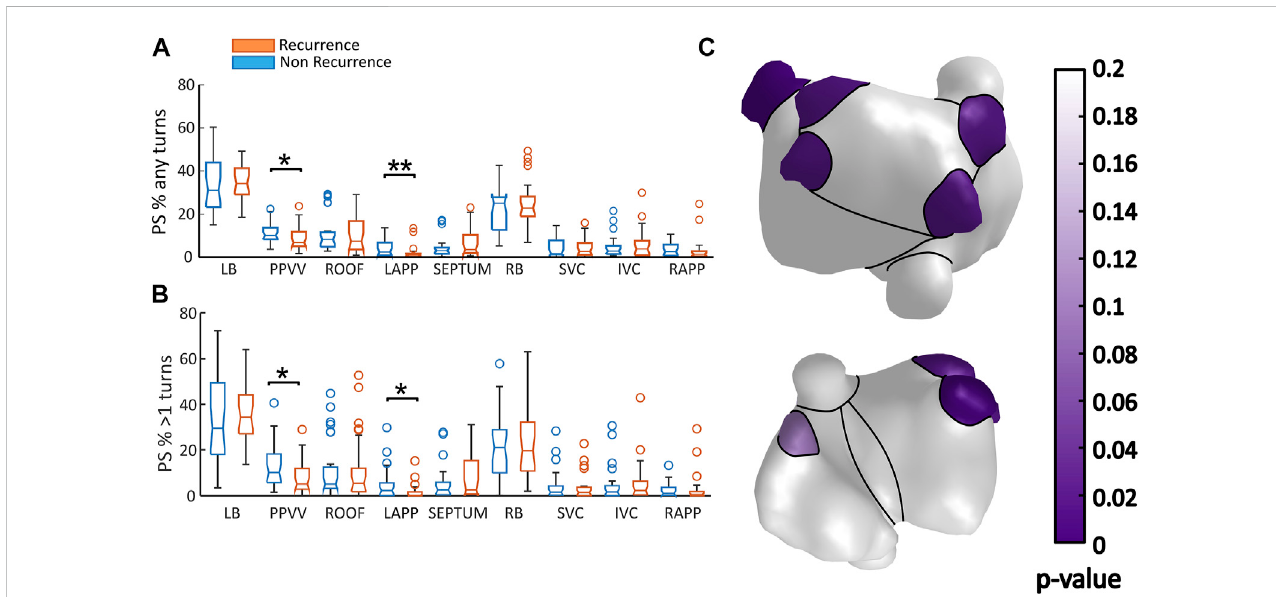
FIGURE 5 (A,B) Proportion of PSs per second detected in different regions in each studied group: in blue is presented the data from patients that remained in sinus rhythm 6 months after ablation (Non-recurrence), and in orange patients that returned to arrhythmia (Recurrence). In panel (A) , are presented the results obtainedwhenallthereentriesareconsideredintheanalysis.Inpanel (B) ,thesameresultsareshown,whenonlythereentrieslastingformorethan1turn.The distribution of the statistical p /values obtained for each regions are presented din panel (C)